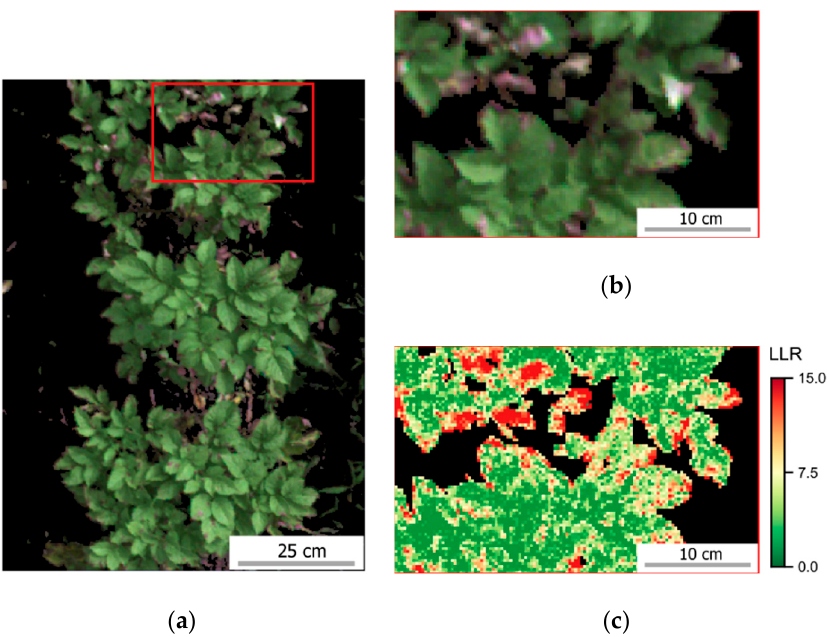
Figure A7. Imaged patch relatively highly affected by late blight 78 DAP (i.e., first sampling unit represented in Figure A6g). Image ( a , b ) corresponds to false color composite for ground image after background removal (620, 542, and 503 nm as RGB bands) and image ( c ) indicates log-likelihood ratio for pixels in the highlighted area in (a, red square), also depicted in ( b ).